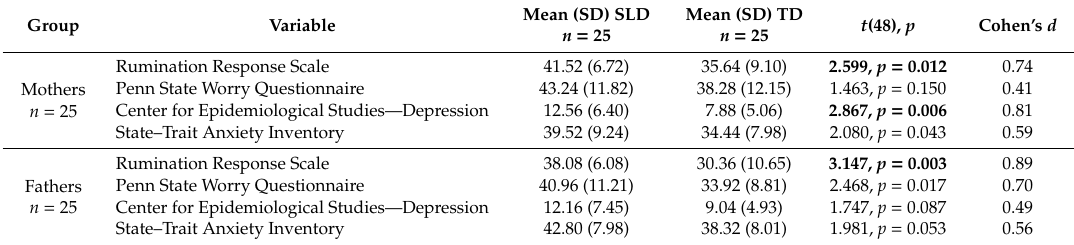
Table 2. Descriptives for mothers’ and fathers’ variables and results of t-tests for group di ff erences.